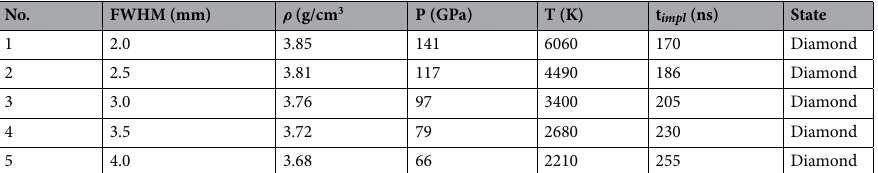
Table 8. Achieved physical conditions in compressed carbon using bunch intensity = 2 × 10 11 uranium ions, bunch length = 200 ns, particle energy = 2 GeV/u, initial sample radius, R si = 200 μm, sample mass = 2.8 mg/